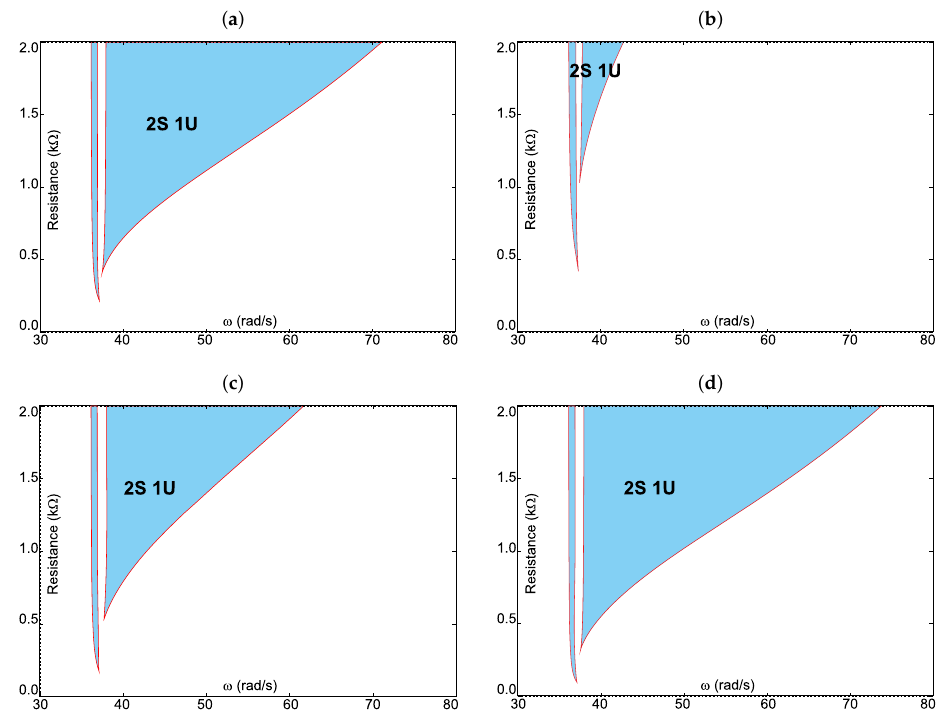
Figure 12. Bifurcation diagram of a two-parameter space. The blue region shows the foldover region. Panel ( a ) shows the result for active segment 1, panel ( b ) for active segment 12, panel ( c ) for segment 13 and panel ( d ) for segment